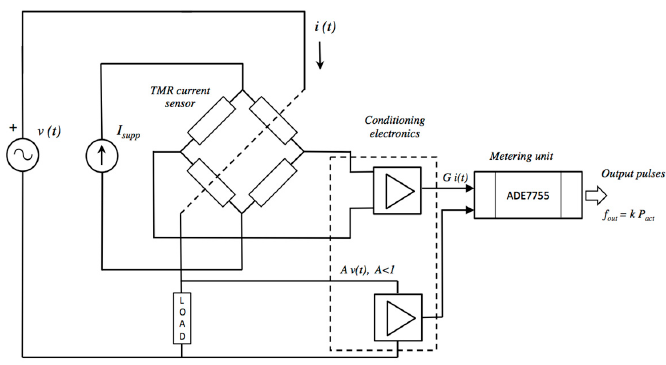
Figure 5. General block diagram of the TMR-based energy meter.